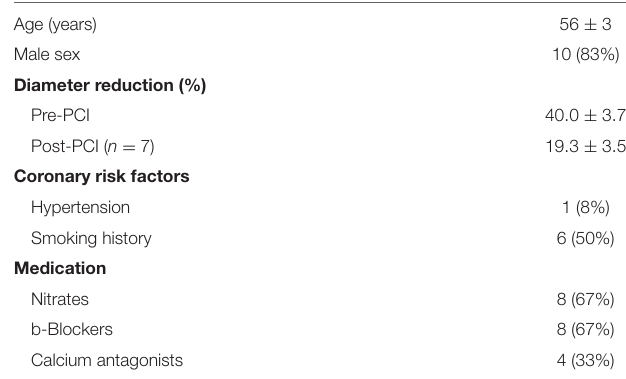
TABLE 1 | Baseline patient characteristics.